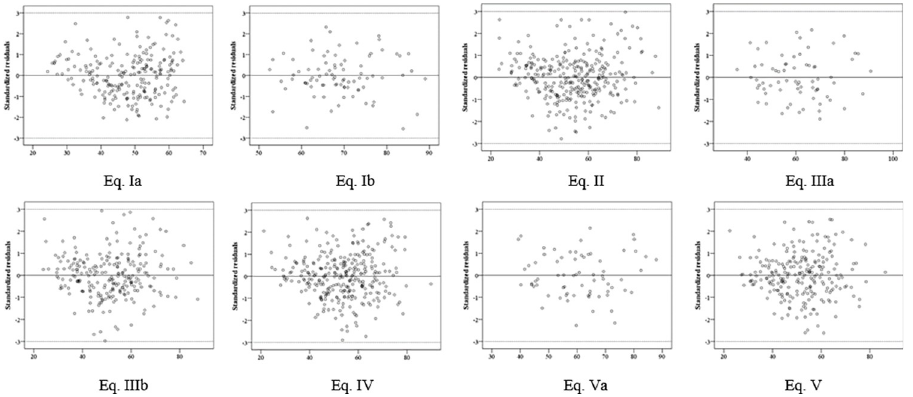
Fig 1. Bland-Altmann plot with residues of developed equations, Brazil,